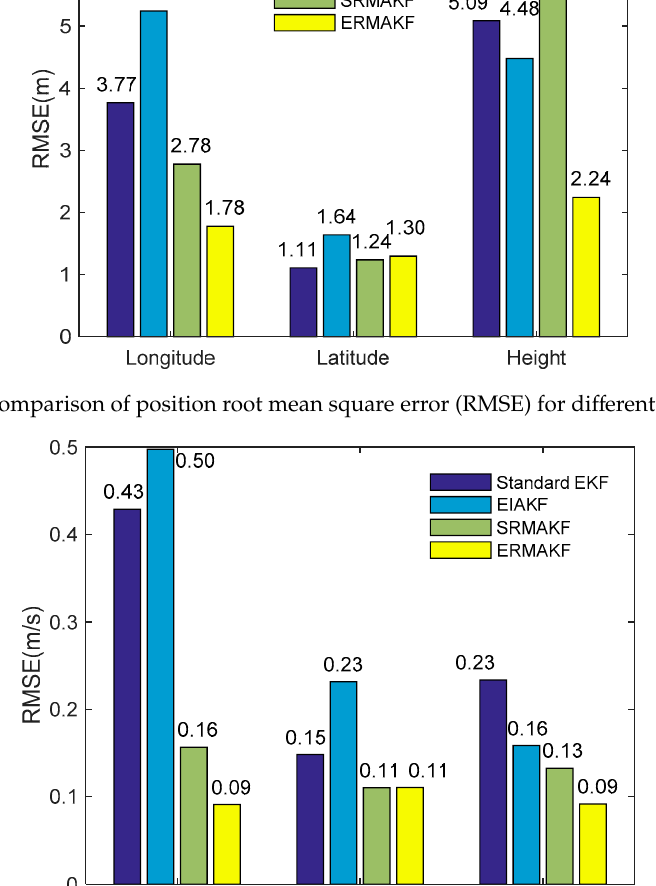
Figure 9. Comparison of velocity RMSE for different algorithms.